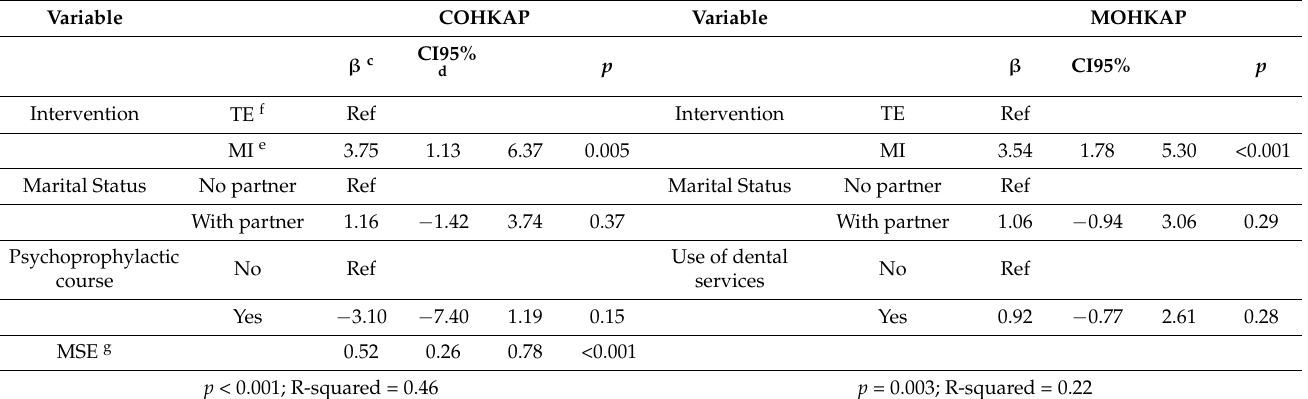
Table 3. Robust multiple linear regression models. Dependent variables total COHKAP and MOHKAP